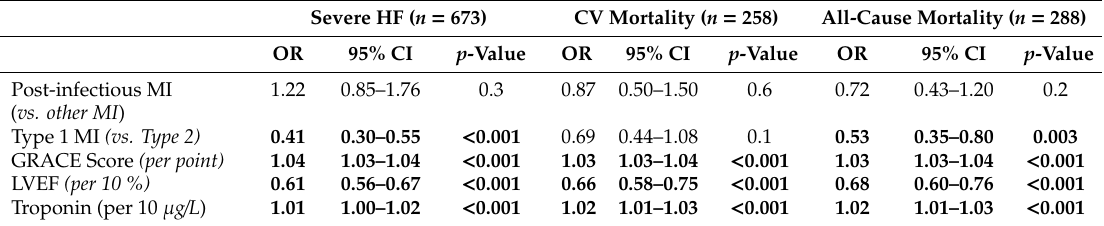
Table 3. Logistic regression analysis of factors associated with main in-hospital outcomes after MI ( n = 4573). Severe HF ( n = 673) CV Mortality ( n =